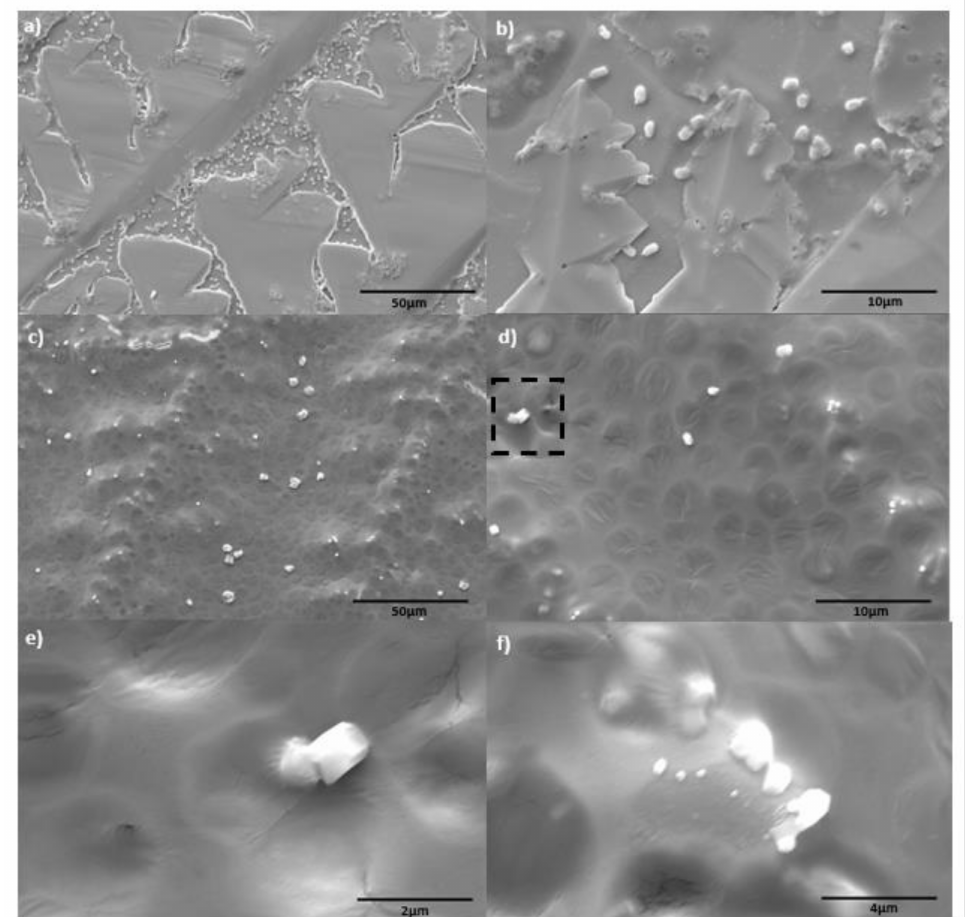
Figure 4. SEM images of HPC-QA/ E. coli PBS sample ( c – f ) and E. coli PBS sample ( a , b ). ( e ) is the enlarged region labeled in ( d